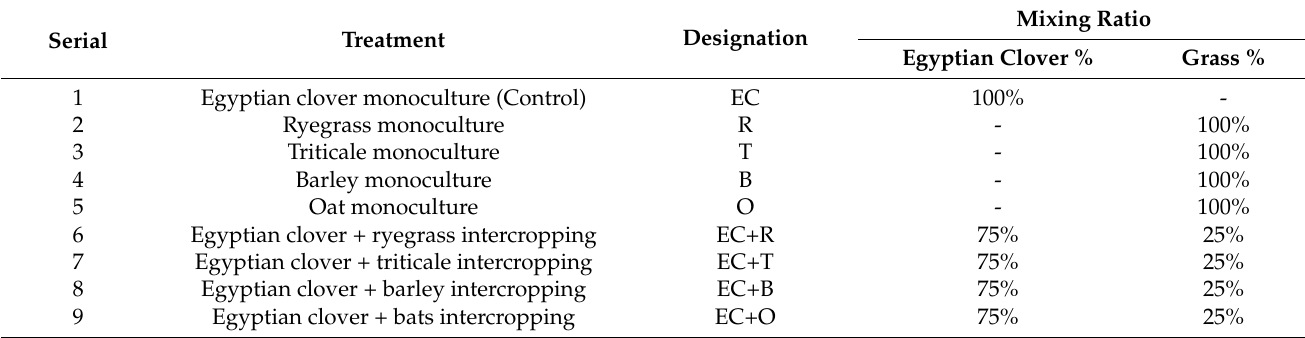
Table 1. Monocultures and intercropping of Egyptian